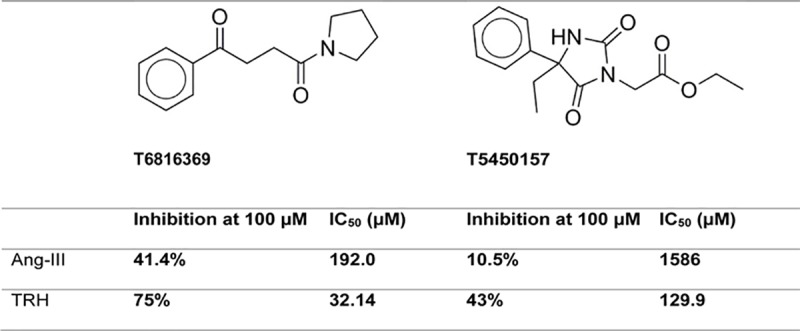
Reduction of POP catalytic action by the two novel inhibitors, shown at the top of the figure.